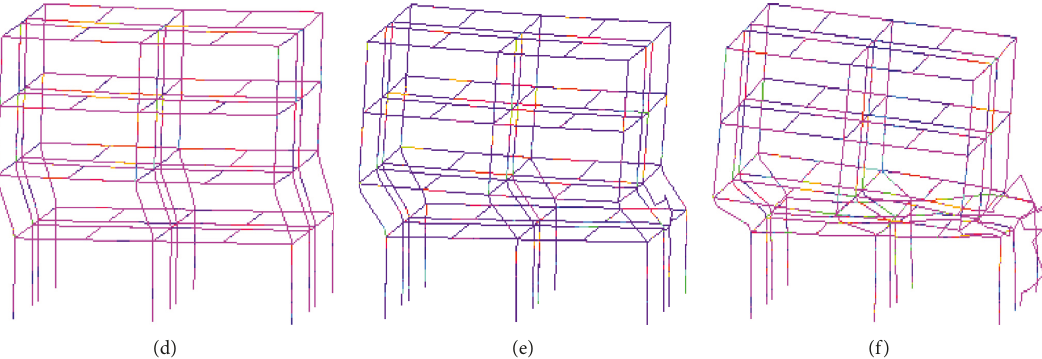
Figure 12: Collapse process of the structure subjected to three-component excitation under El Centro wave considering strain rate effect. (a)